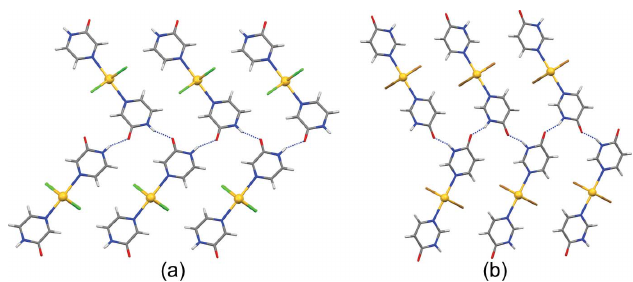
Figure 8 The relative orientations of adjacent polymeric chains ( Mercury 3.3 , capped sticks) in the crystal structures of ( a ) [CdCl 2 (2-pyz) 2 ] n ( 1 ) and ( b ) [CdBr 2 (2-pym) 2 ] n ( 5 ) linked via one single-point N—H (cid:2)(cid:2)(cid:2) O hydrogen bond forming extended C (4) chains. [CdBr 2 (2-pyz) 2 ] n ( 2 ) and [CdI 2 - (2-pyz) 2 ] n ( 3 ) exhibit the same supramolecular architecture as 1 , and [CdI 2 (2-pym) 2 ] n ( 6 ) the same as 5